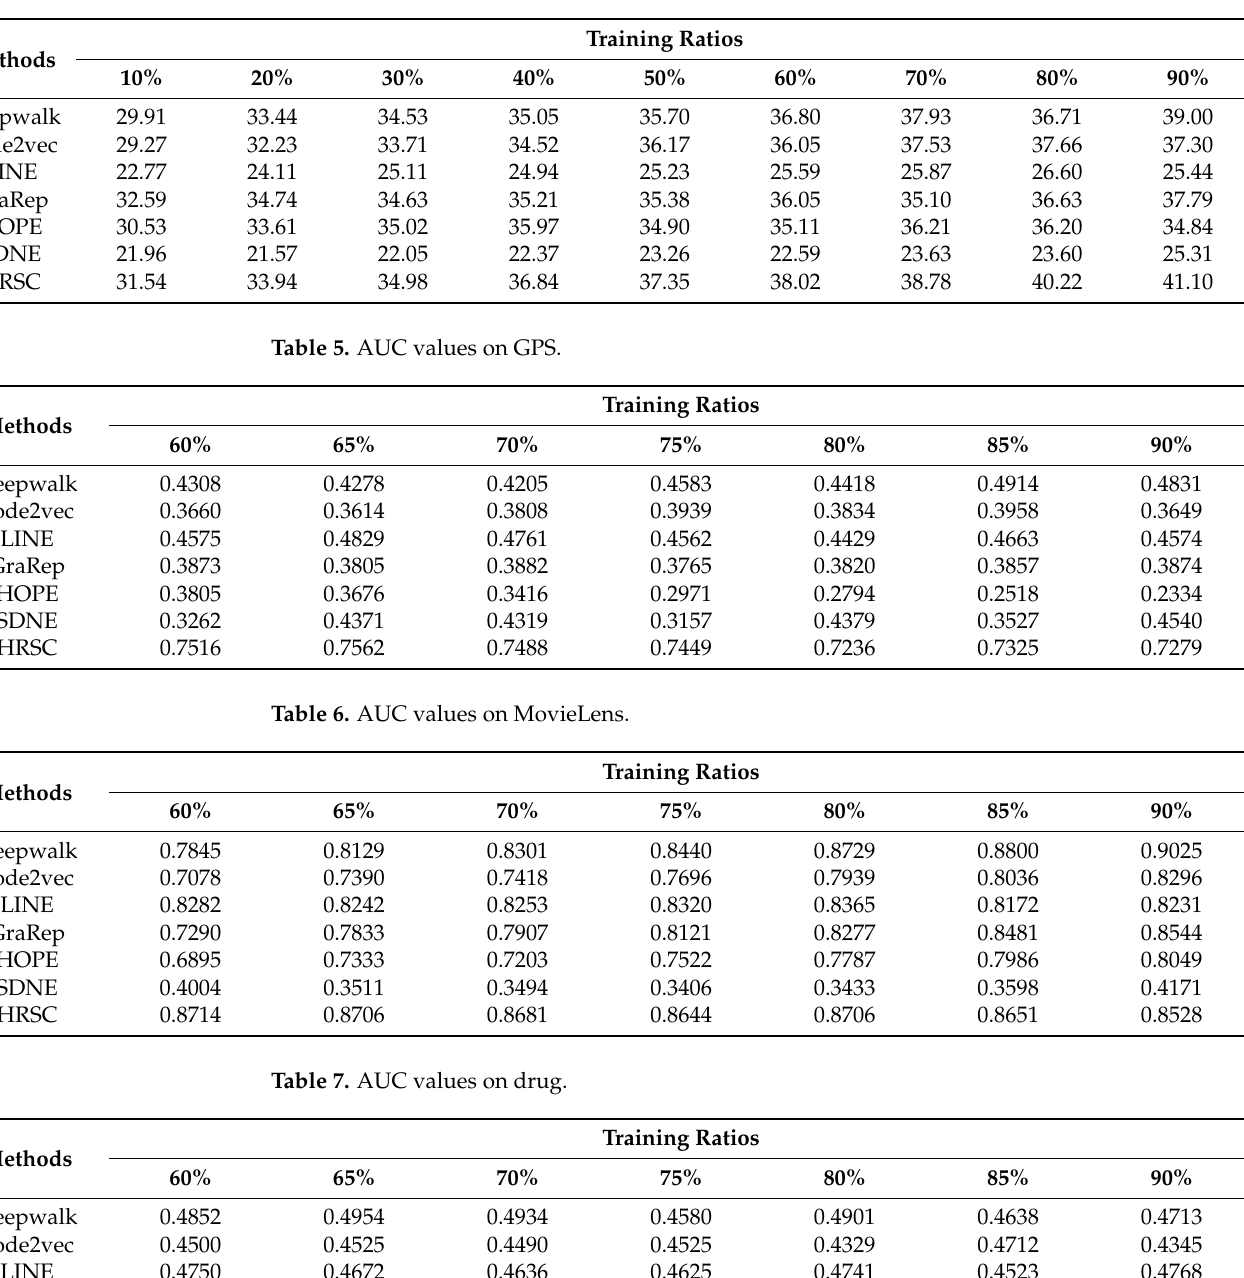
Table 4. Node classification accuracies on wordnet (%).